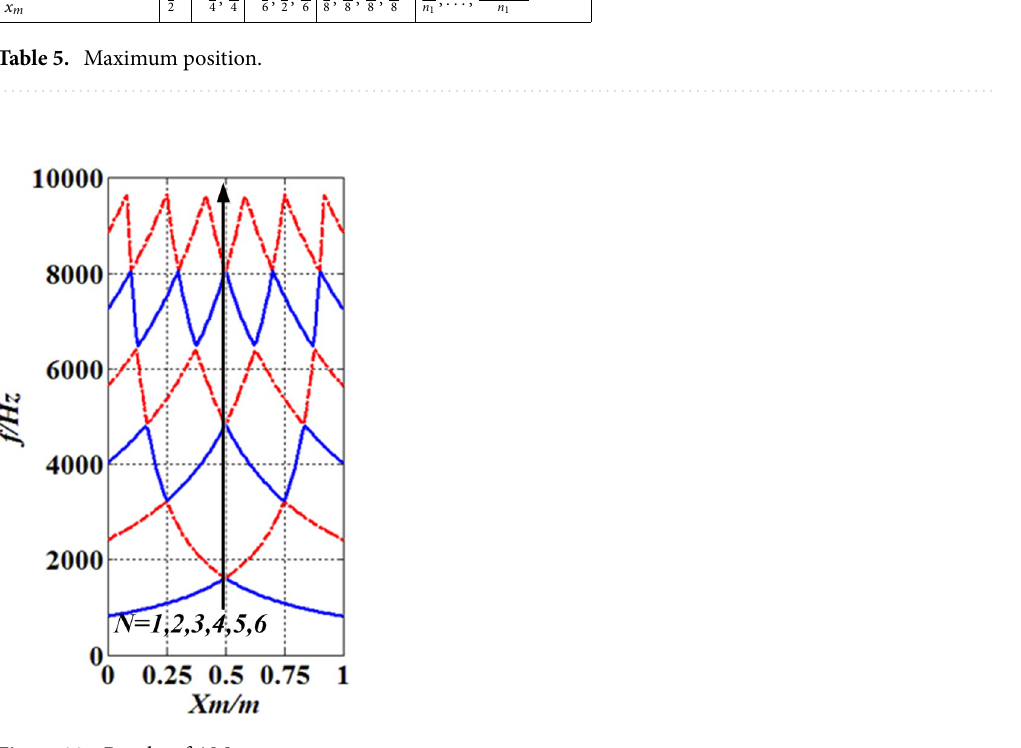
Figure 22. Results of